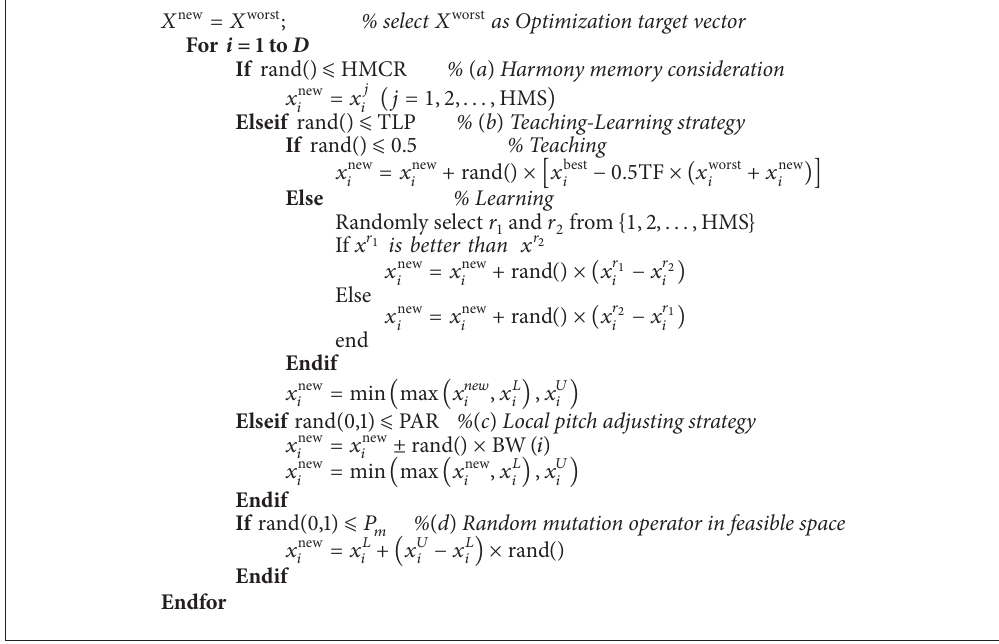
Algorithm 7: Improvisation of new harmony in HSTL algorithm.